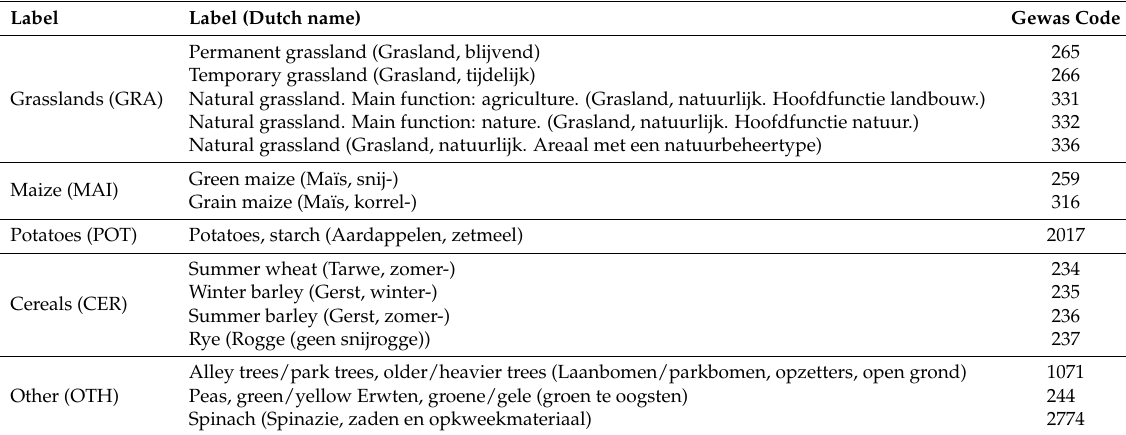
Table A1. Aggregation of the crops for the ground-truth